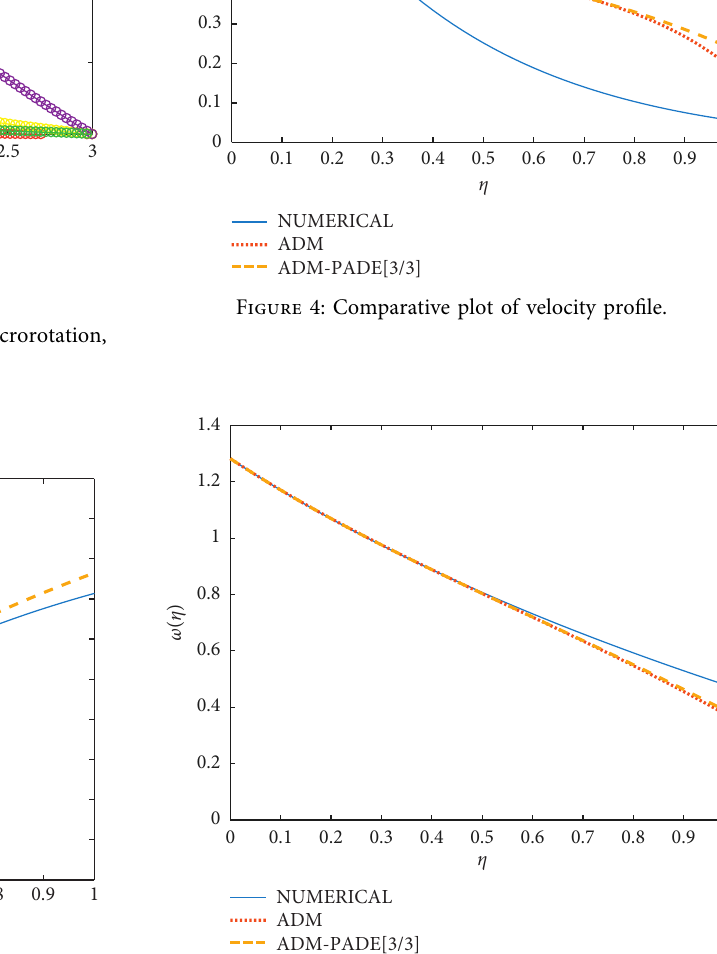
Figure 5: Comparative plot of microrotation